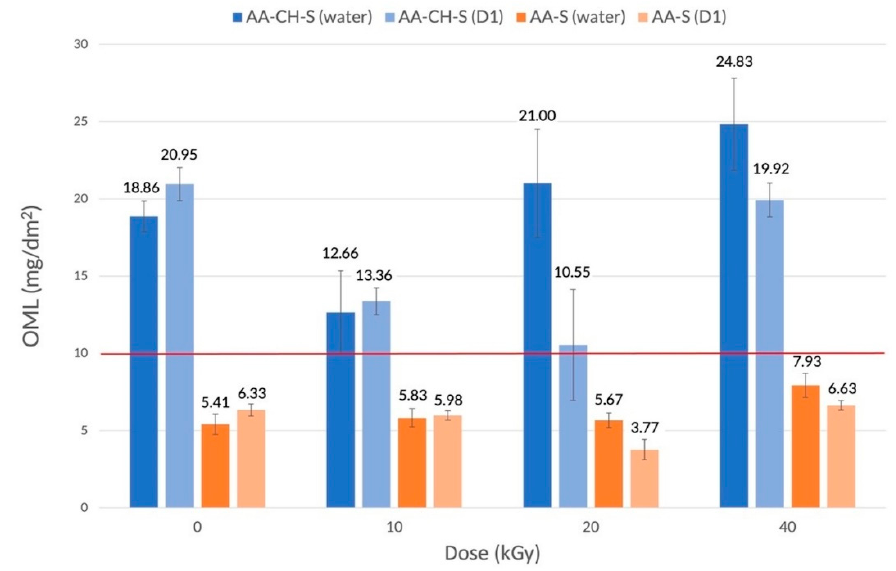
Figure 3. Global migration of AA-CH-S (blue) and AA-S (orange) films in two model solutions (water; D1).